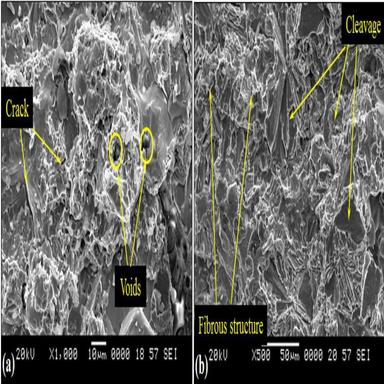
Micrographs showing tensile fractured surfaces of the specimens developed with 900 W power.